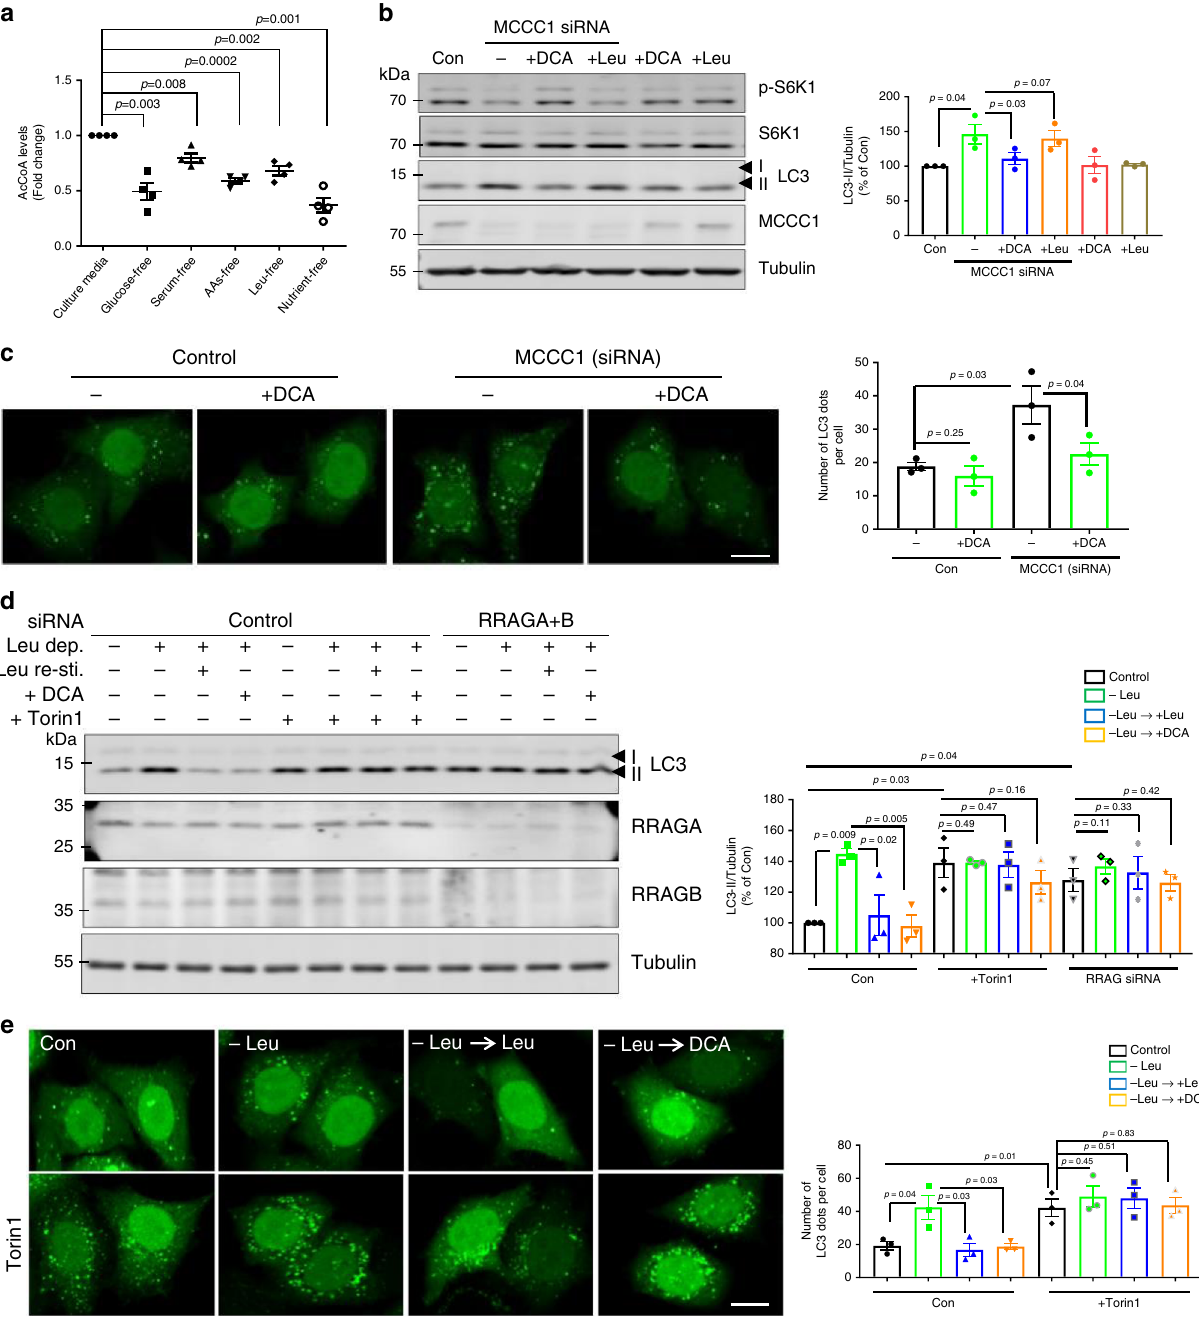
Fig. 3 AcCoA is essential for Leu metabolism-mediated autophagy regulation. a AcCoA levels were assessed using the PicoProbe AcCoA assay kit. HeLa cells were incubated in nutrient-depleted conditions for 4 h followed by lysis and measurement of AcCoA levels. N = 4. Two-tailed unpaired t -test. b Effect of DCA and Leu on mTOR signaling and autophagy modulation caused by MCCC1 knockdown. Control cells, and cells treated with MCCC1 siRNA were treated with 10 mM DCA or 10 µ M Leu for 1 h. Cells were lysed and western blots for phosphorylated S6K1 (p-S6K1) and total S6K1, as well as LC3 and MCCC1 are shown. N = 3. Two-tailed unpaired t -test. c Rescue of activated autophagy in MCCC1-depleted cells by DCA. 10 mM DCA for 1 h treatment restored the increased LC3 dots in MCCC1-depleted cells. N = 3, 60 – 70 cells scored per condition per experiment. Two-tailed unpaired t -test. Scale bar, 10 μ m. AcCoA-induced autophagy regulation in mTORC1-dependent manner. Treatment with 0.5 µ M Torin1 for 4 h or RRAGA and RRAGB double- knockdown (RRAGA + B) blocked the rescue effect of Leu or DCA on autophagy activation (LC3-II level ( d ) and LC3 dots ( e )) by Leu depletion. HeLa cells were treated with scrambled siRNA or MCCC1 siRNA then incubated in Leu-depleted media for 4 h or incubated in Leu-depleted media for 4 h, followed by the re-addition of 10 µ M of Leu or 10 mM DCA to the media for 1 h. N = 3, 40 – 50 cells scored per condition per experiment. Two-way ANOVA with post- hoc Tukey ’ s multiple comparison test. Scale bar, 10 μ m. Data are presented as mean values± SEM. Source data are provided as a Source data fi